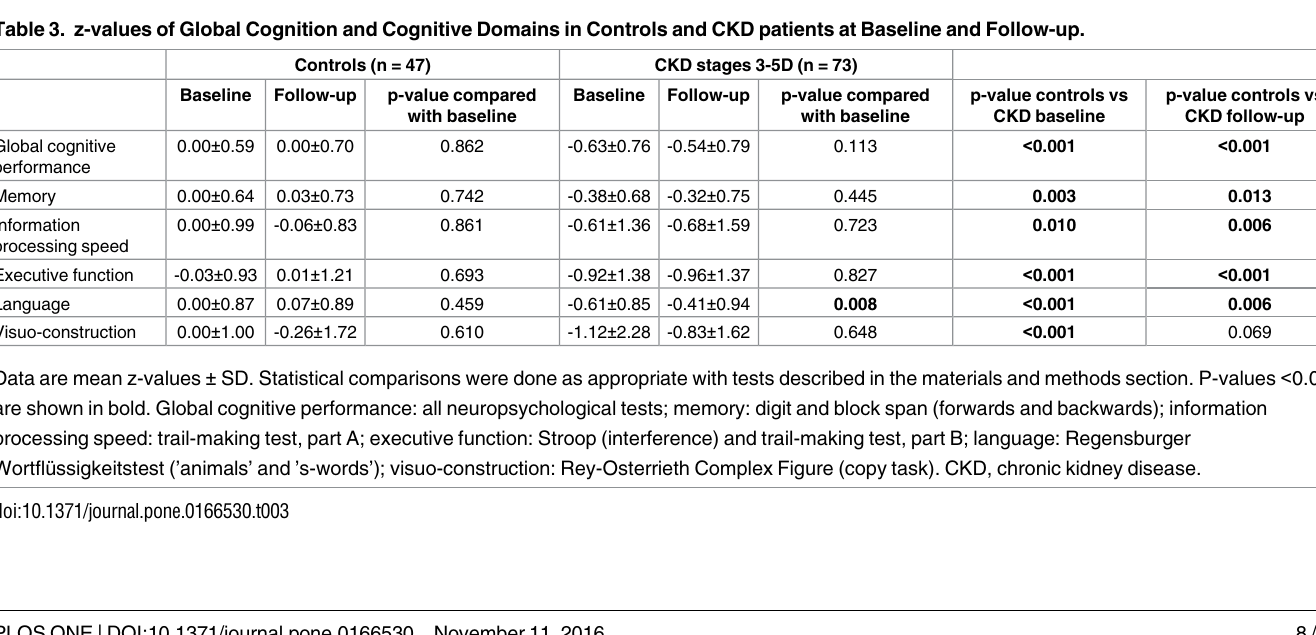
HADS, anxiety scale (score)